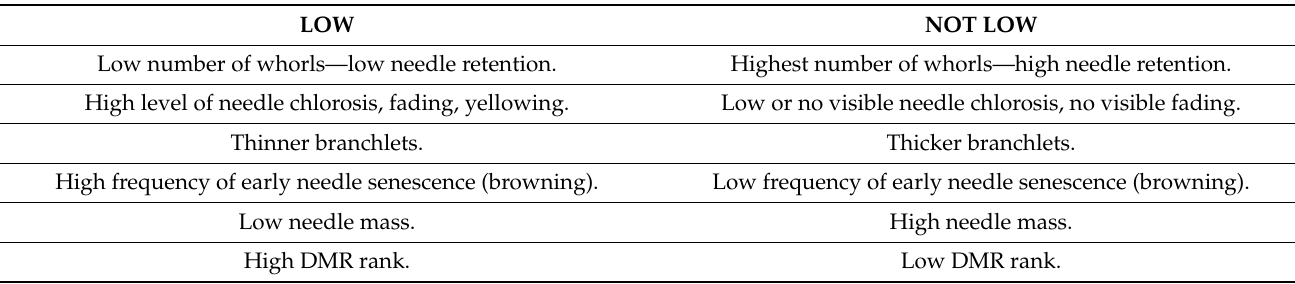
Table 2. Whole-tree and branch characteristics used in assigning qualitative-vigor classes to ponderosa pine individual tree crowns (ITCs). DMR is the dwarf mistletoe rating. LOW NOT LOW Low number of whorls—low needle retention. Highest number of whorls—high needle retention. High level of needle chlorosis, fading, yellowing. Low or no visible needle chlorosis, no visible fading. Thinner branchlets. Thicker branchlets. High frequency of early needle senescence